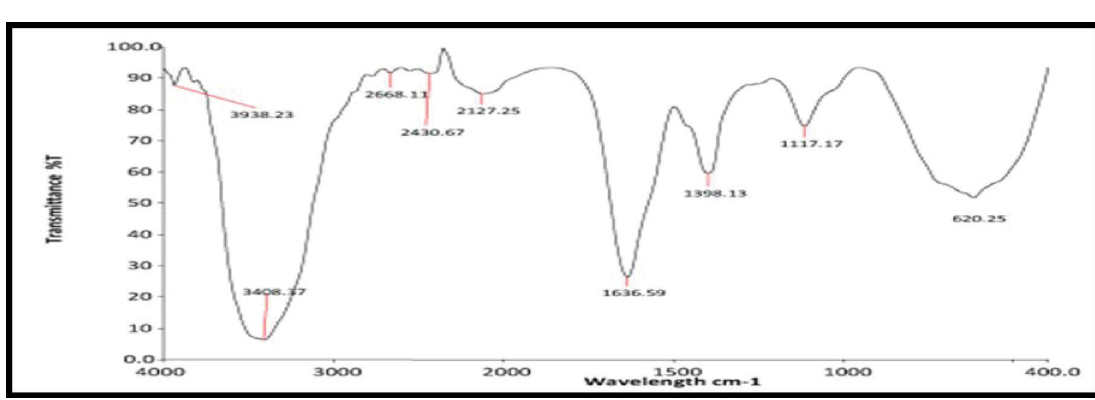
FIGURE 1 - I.R. Spectra of Trachyspermum ammi.